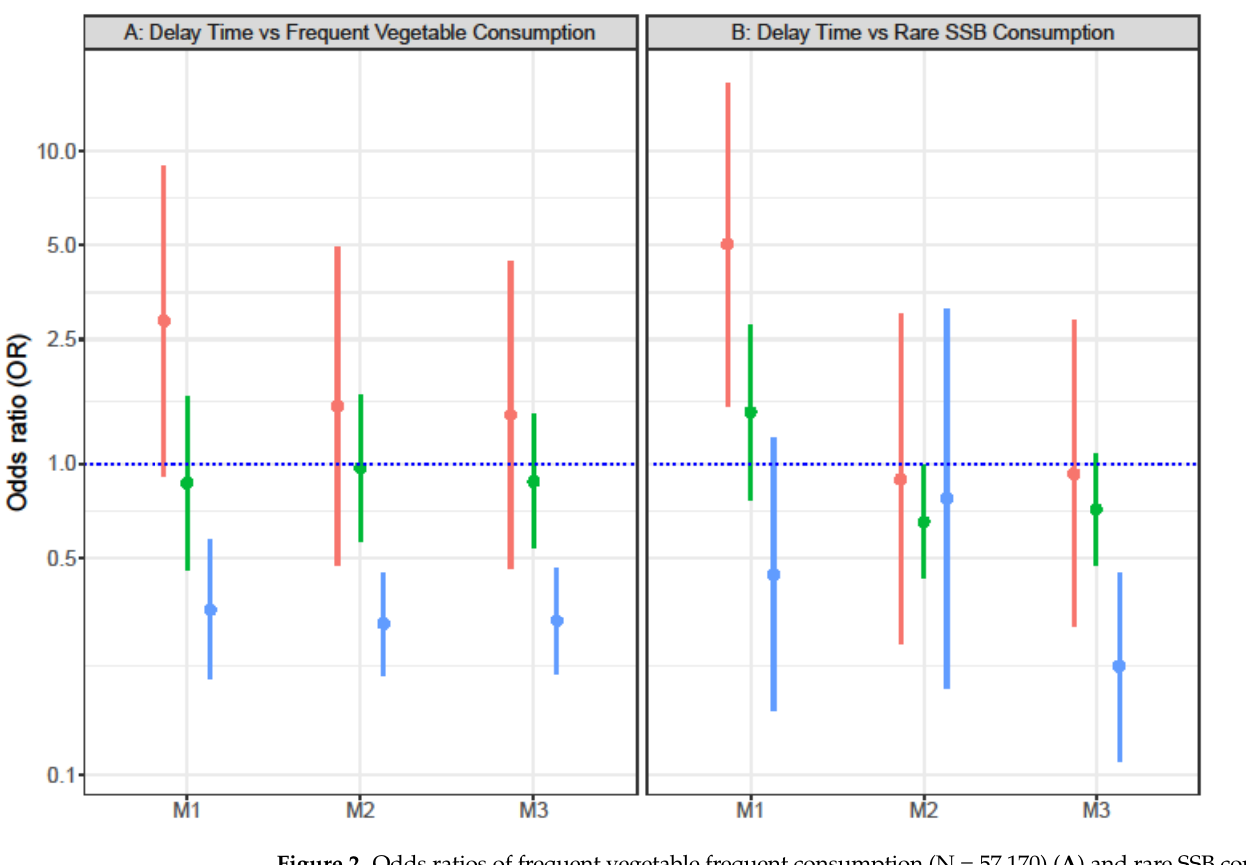
Figure 2. Odds ratios of frequent vegetable frequent consumption (N = 57,170) ( A ) and rare SSB consumption (N = 42,117) ( B ), associated with city level delay time in LA cities, stratified by city size area tertiles. Panel A includes National Health Surveys from Brazil, Colombia, Mexico, Chile, and Peru. Panel B includes National Health Surveys from Brazil, Colombia, and Mexico. M1: + age + sex + education + car ownership. M2: M1 + population density + intersection density + adjusted gas price + presence of mass transportation. M3: M2 + Social environment index.